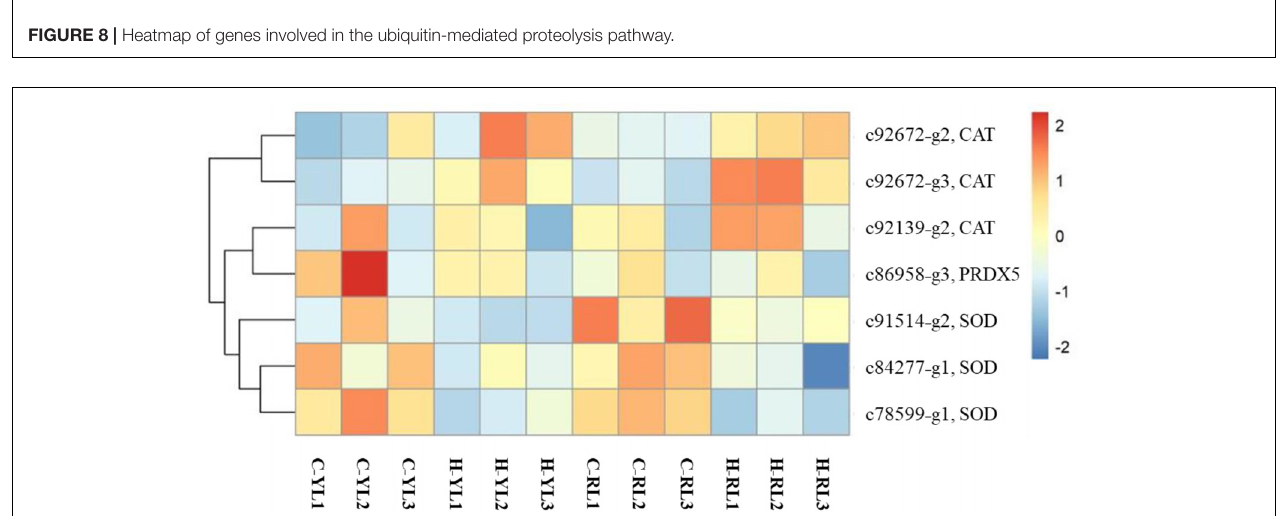
FIGURE 9 | Heatmap of differentially expressed antioxidant-related genes. CAT, catalase; SOD, superoxide dismutase; PRDX5, peroxiredoxin 5.